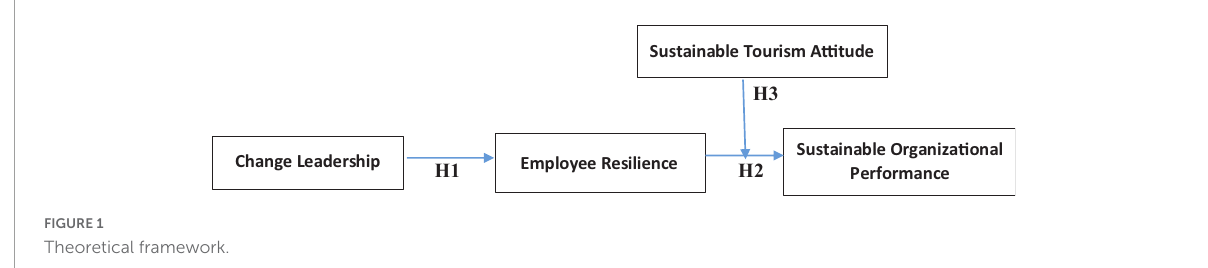
FIGURE1 Theoretical